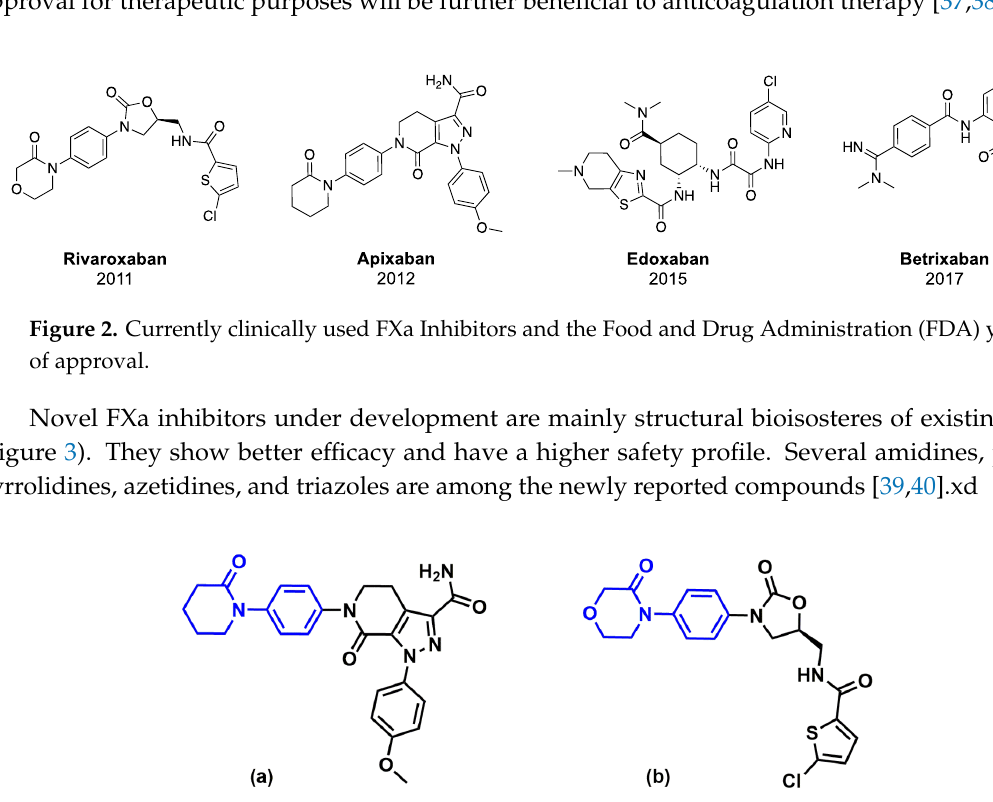
scaffolds phenyloxopiperidine or phenyloxomorphonilo are highlighted in blue. sca ff olds phenyloxopiperidine or phenyloxomorphonilo are highlighted in